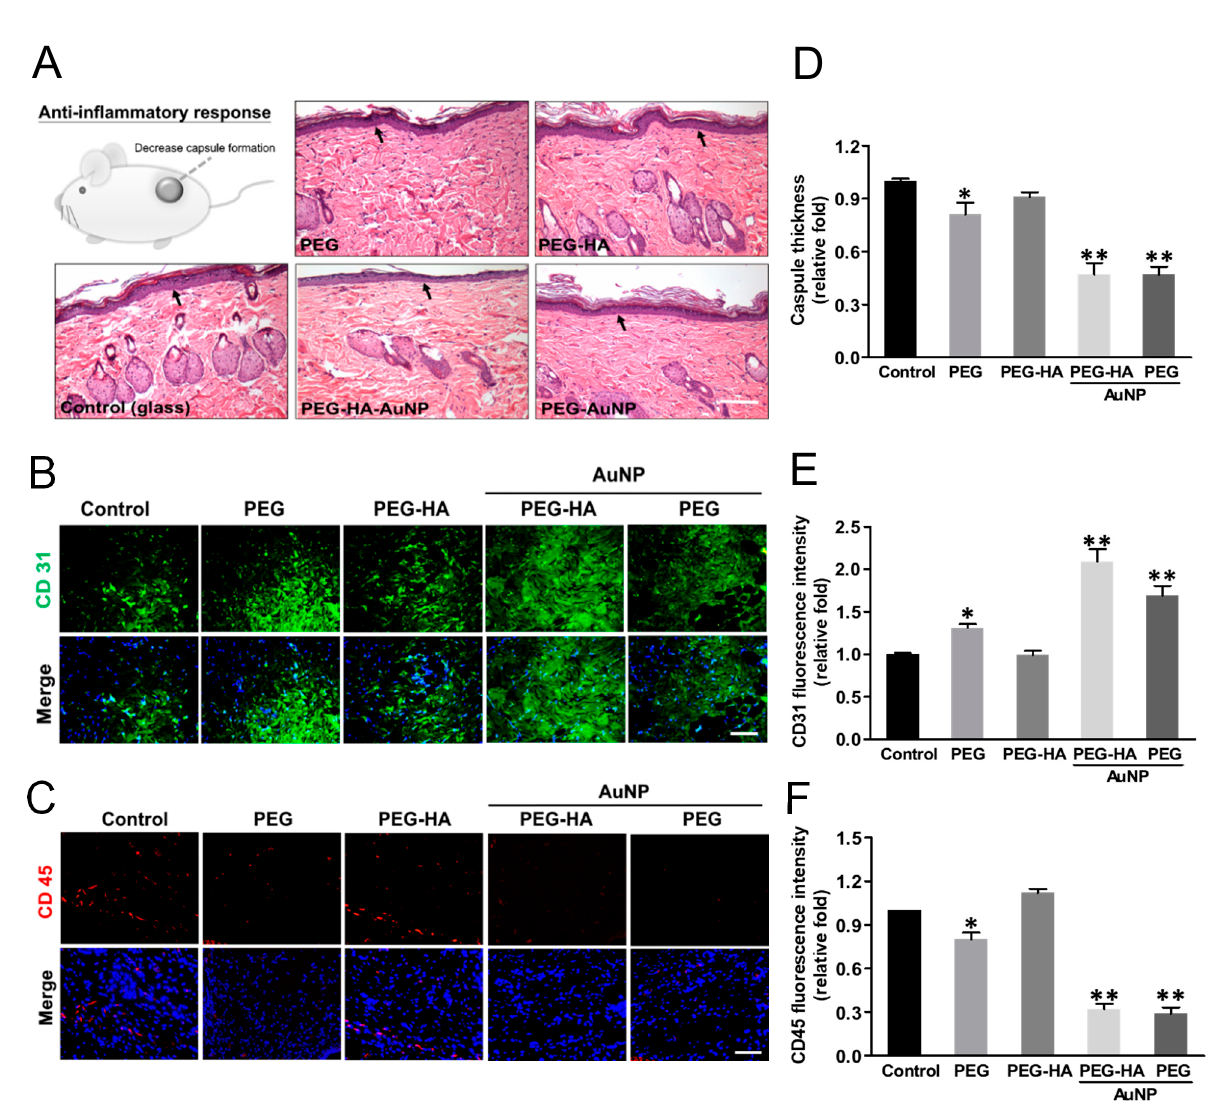
Figure 9. Evaluation of foreign body response of different substrates after subcutaneous implantation. Histology of H&E-stained sections and IHC staining after implantation of material for 4 weeks. ( A ) FBR is exhibited by the capsule thickness (arrows) based on the histology examination. The scale bar is 100 µ m. ( B ) Immunofluorescence staining of CD31 (marker of endothelialization), and ( C ) CD45 (marker of immunoflammation) in response to the implant materials. The scale bar is 100 μ m. Quantification of ( D ) capsule thickness, and ( E ) CD31 and ( F ) CD45 fluorescence intensities. Data are mean SD. * p < 0.05, ** p < 0.01: greater than control (glass). The number of rats was 5 ( n = 5).